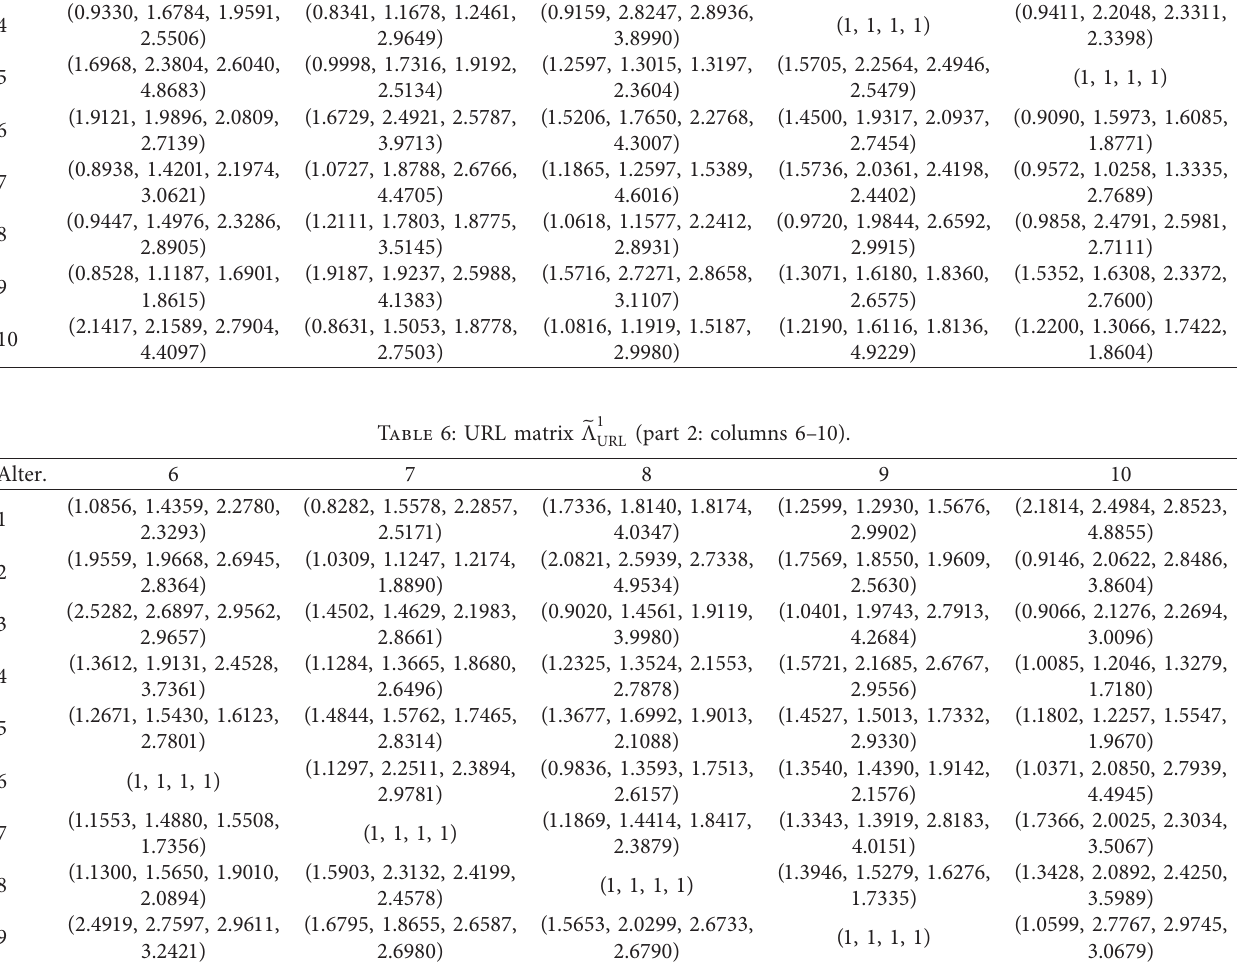
Table 7: Real number form matrix Λ 1